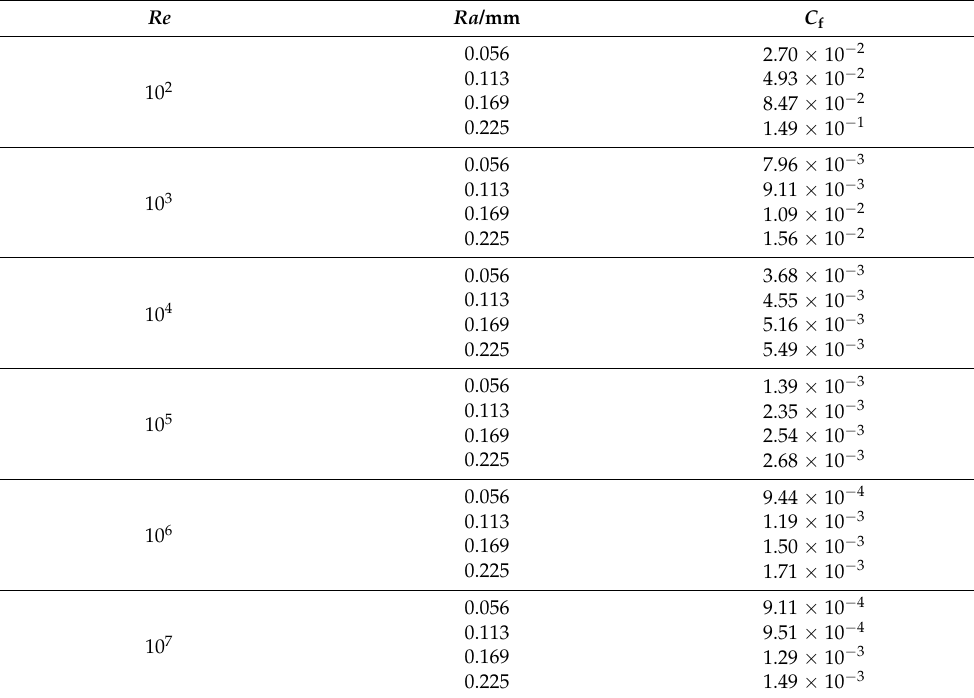
Table 4. Values of C f versus Re for η ranging from 0.056 to 0.225 at Ra = 0.8 µ